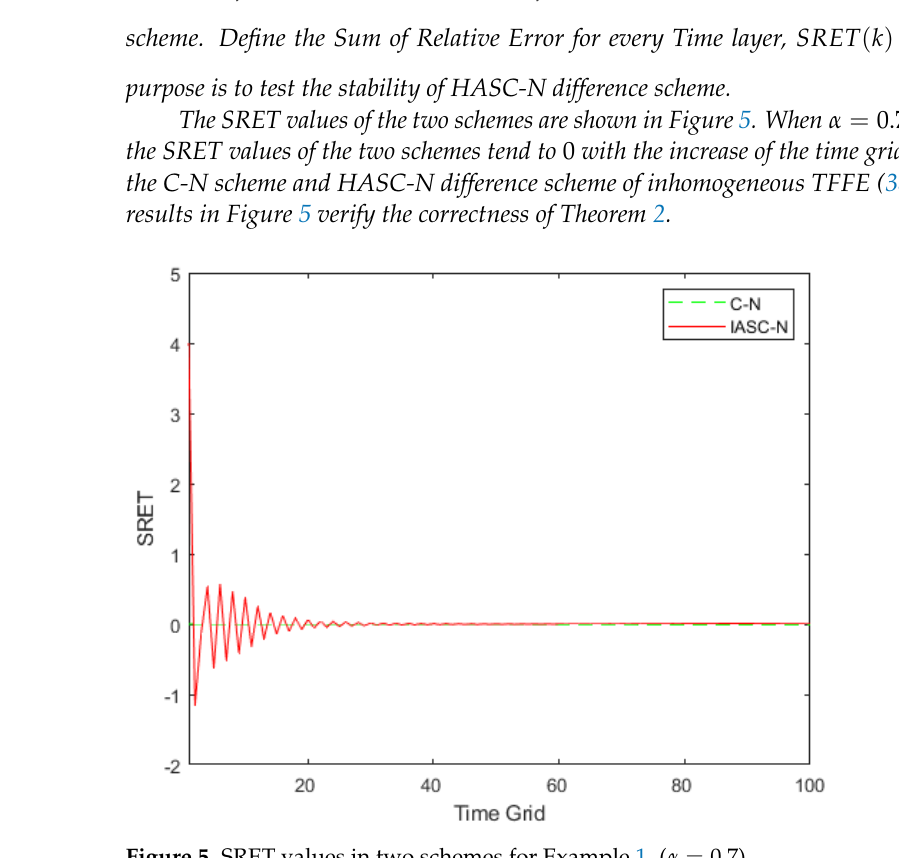
Figure 5. SRET values in two schemes for Example 1. ( α =